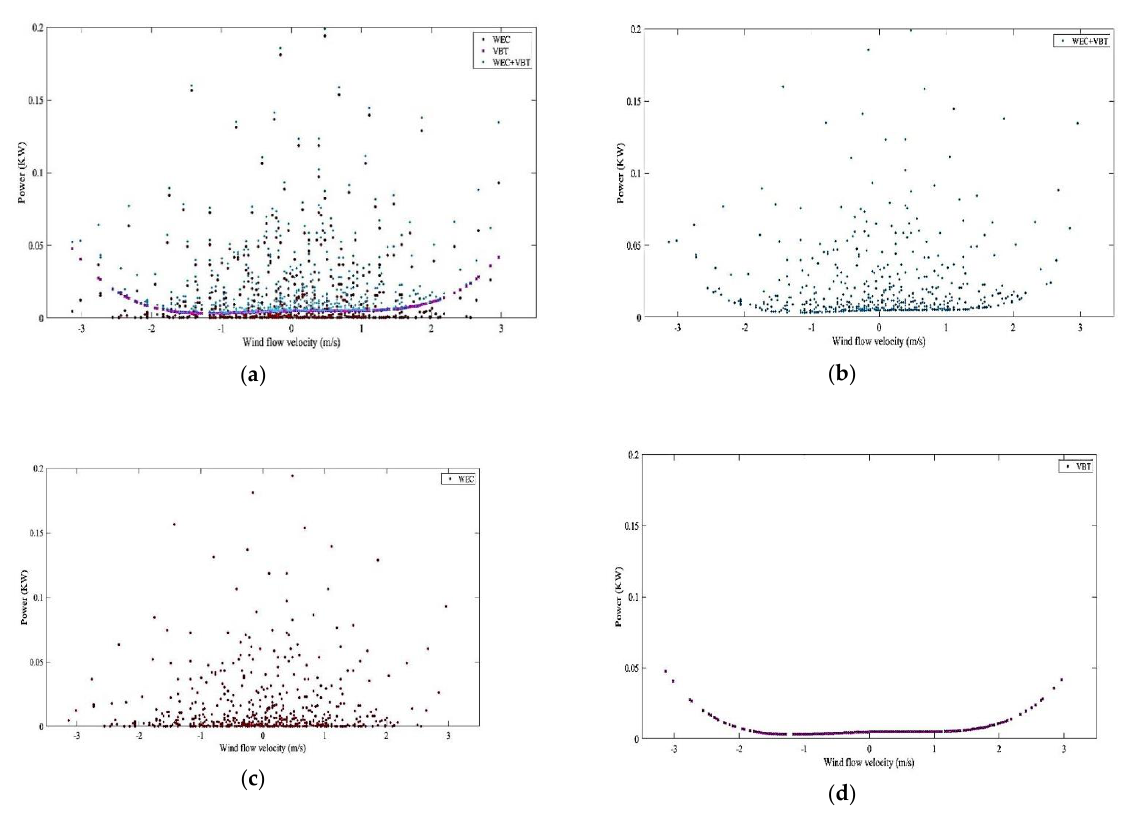
Figure 8. ( a ) Illustration of the energy generated by WEC and VBT, individually and combined: ( b )